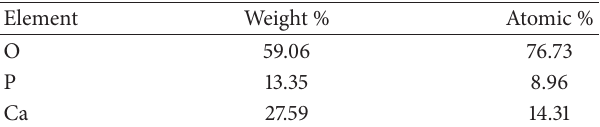
Table 1: EDX of HA powder.